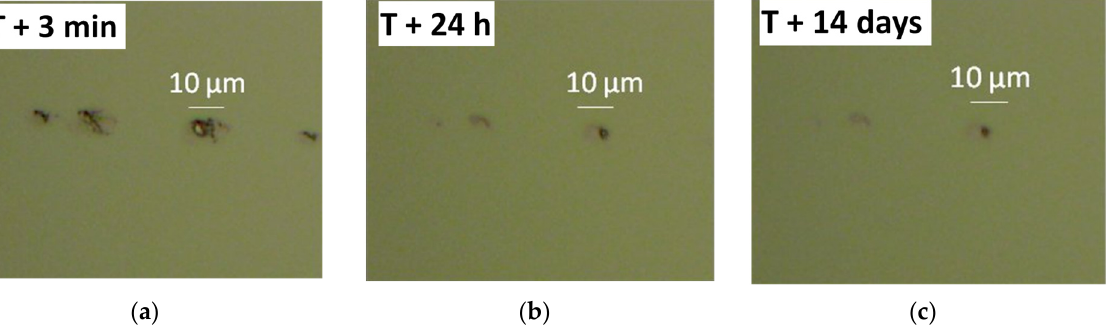
Figure 1. Indented layer evolution of a 40 wt.% PDMS-based ormosil at t = 3 min ( a ), t = 24 h ( b ), and at t = 14 days ( c ).